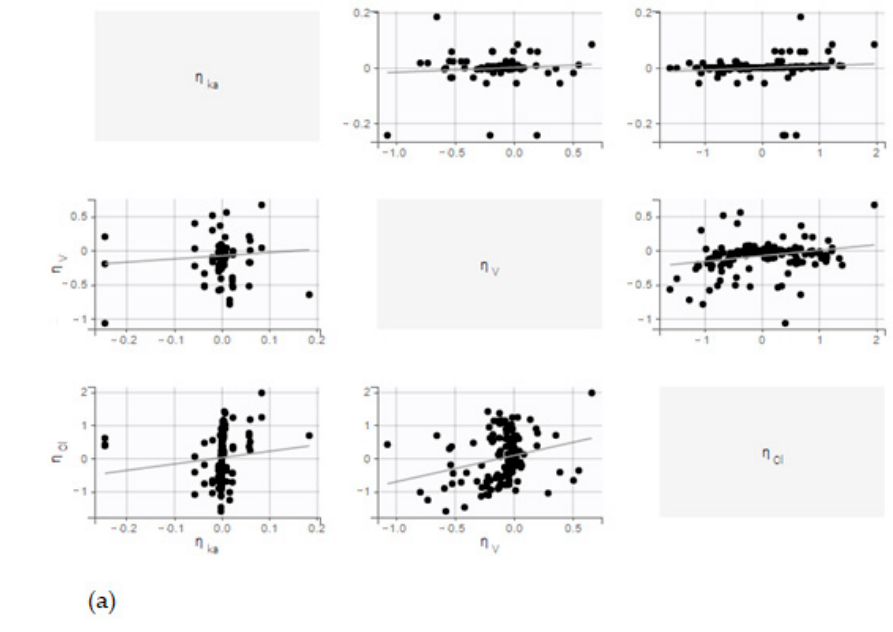
Figure 4. Distribution of parameters.